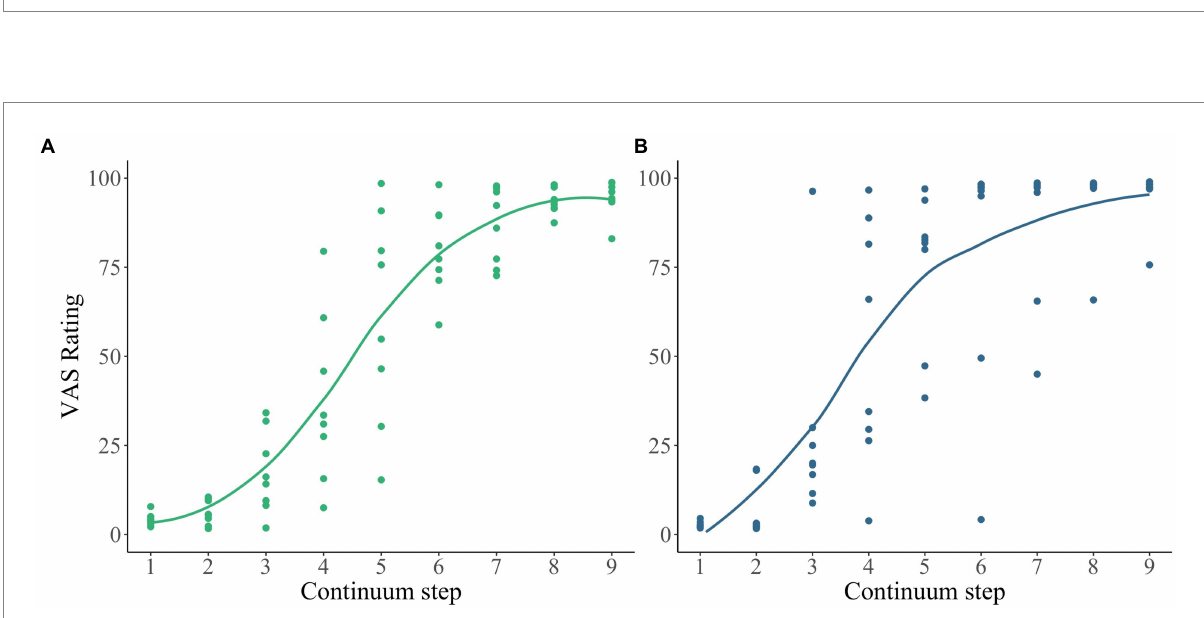
FIGURE 4 VAS ratings for four groups created based on Age of Acquisition of English and Spanish. Across four groups both Spanish as a second language and Spanish-English heritage speakers have the highest amplitudes. Spanish-English heritage speakers follow a more gradient slope compared to Spanish as a second language